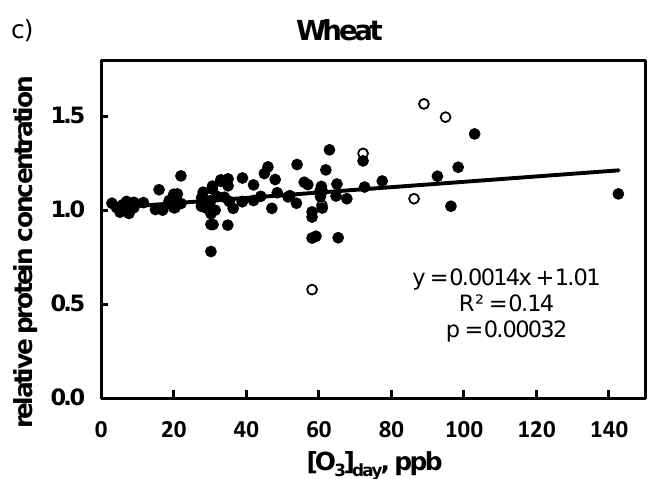
Figure 2. Relationship between relative seed protein concentration (SPC) and daytime O 3 concentration, [O 3 ] day , for ( a ) soybean; ( b ) rice; ( c ) wheat. Open circles denote data points representing statistical outliers for at least one of the studied response variables.